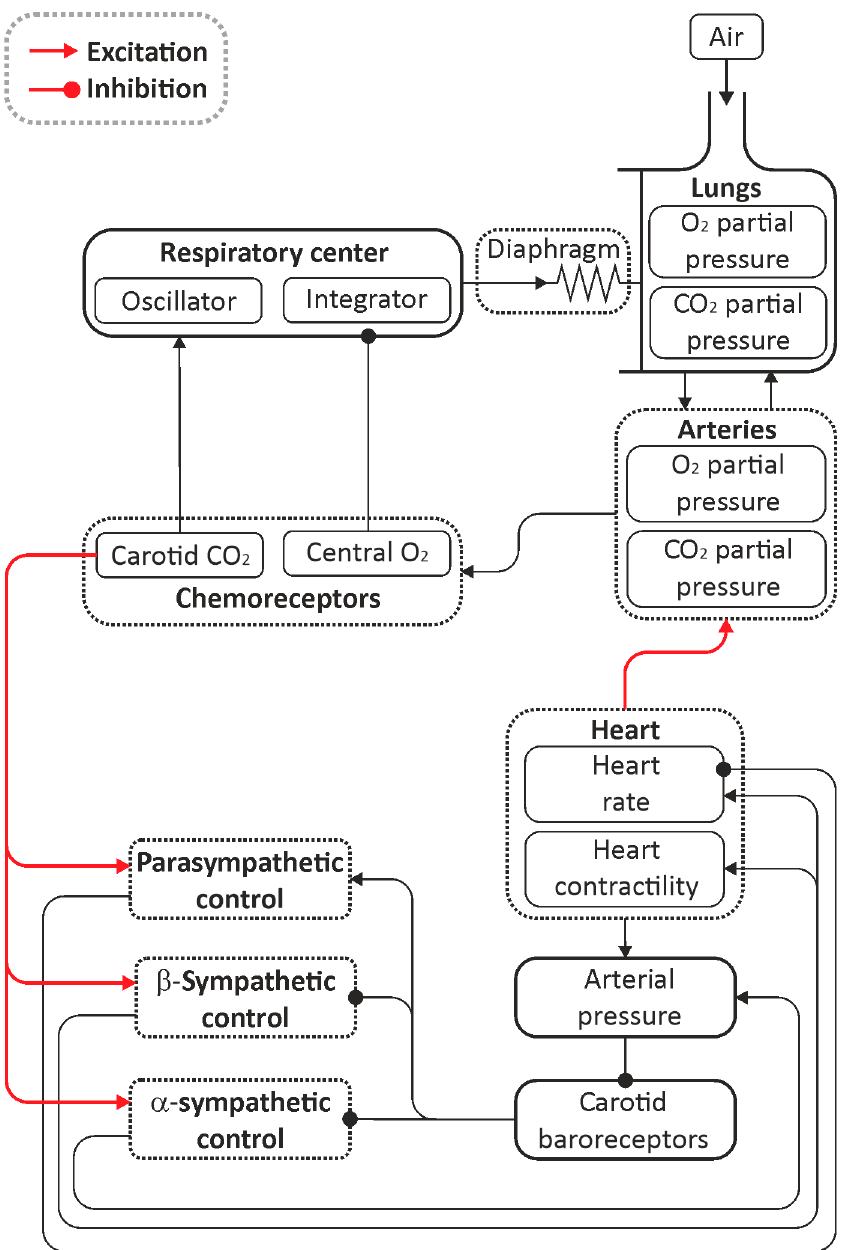
Figure 1. Structure of the proposed mathematical model of the respiratory and cardiovascular systems. Red arrows show the cardiorespiratory